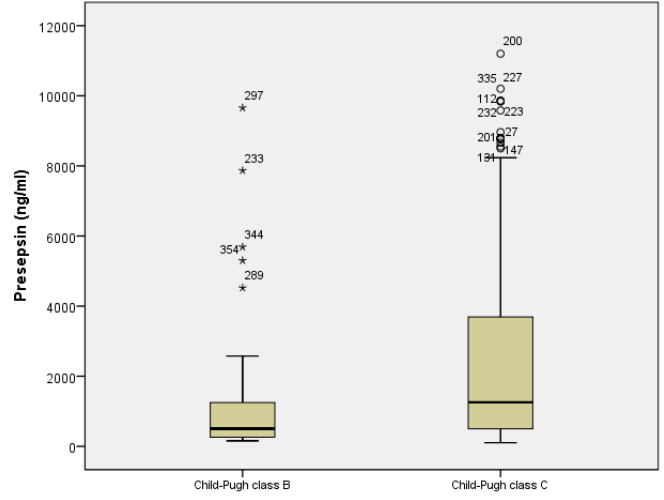
Figure 2. Relationship between presepsin level and liver cirrhosis severity.